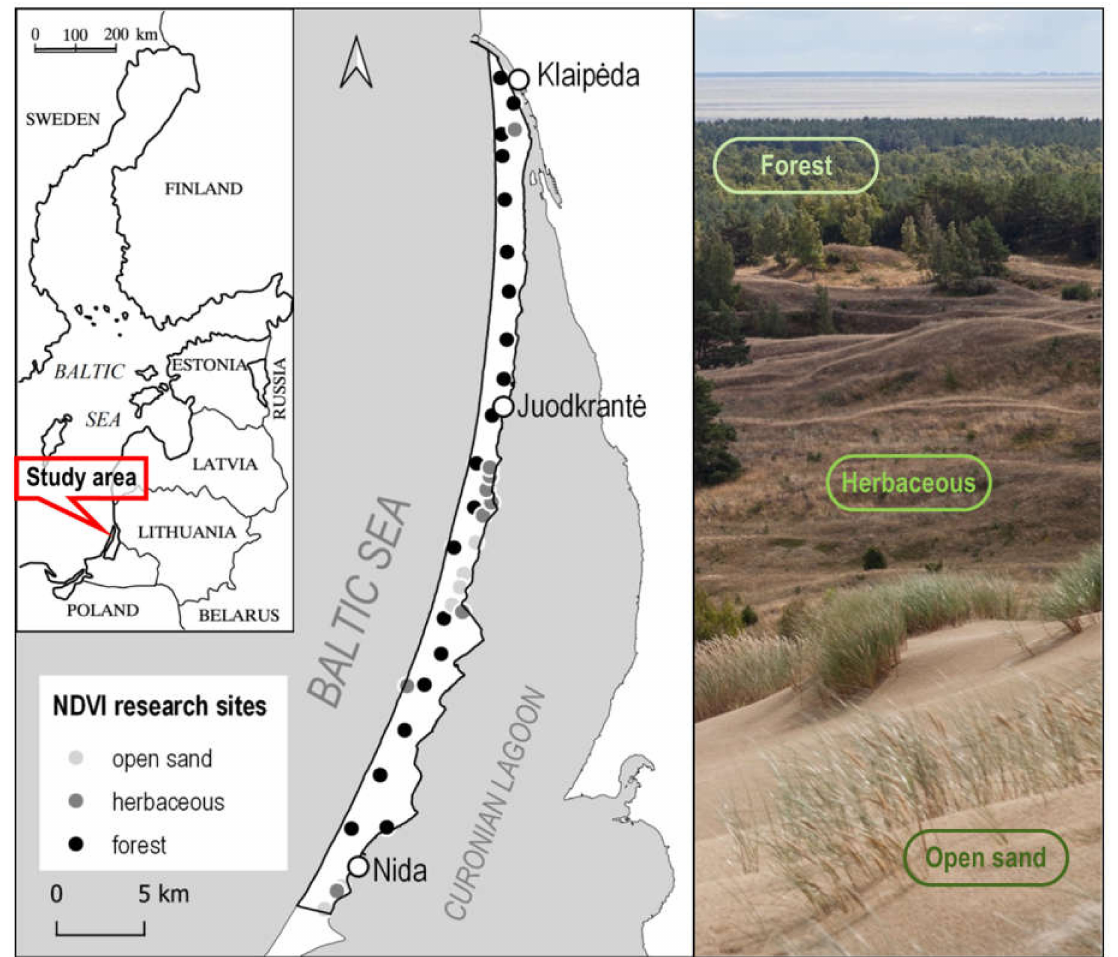
Figure 1. Location of research sites and typical view of studied ecosystem from sea to